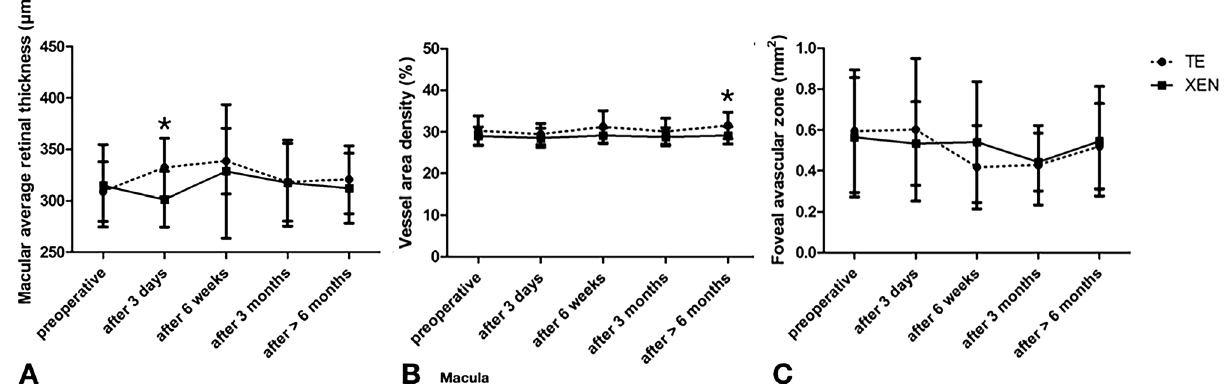
Figure 4. Change in ( A ) average retinal thickness (in µm), ( B ) macular vessel area density (in percentage) and ( C ) foveal avascular zone (in mm 2 ) for the follow-up intervals. *marked significant differences between both treatment